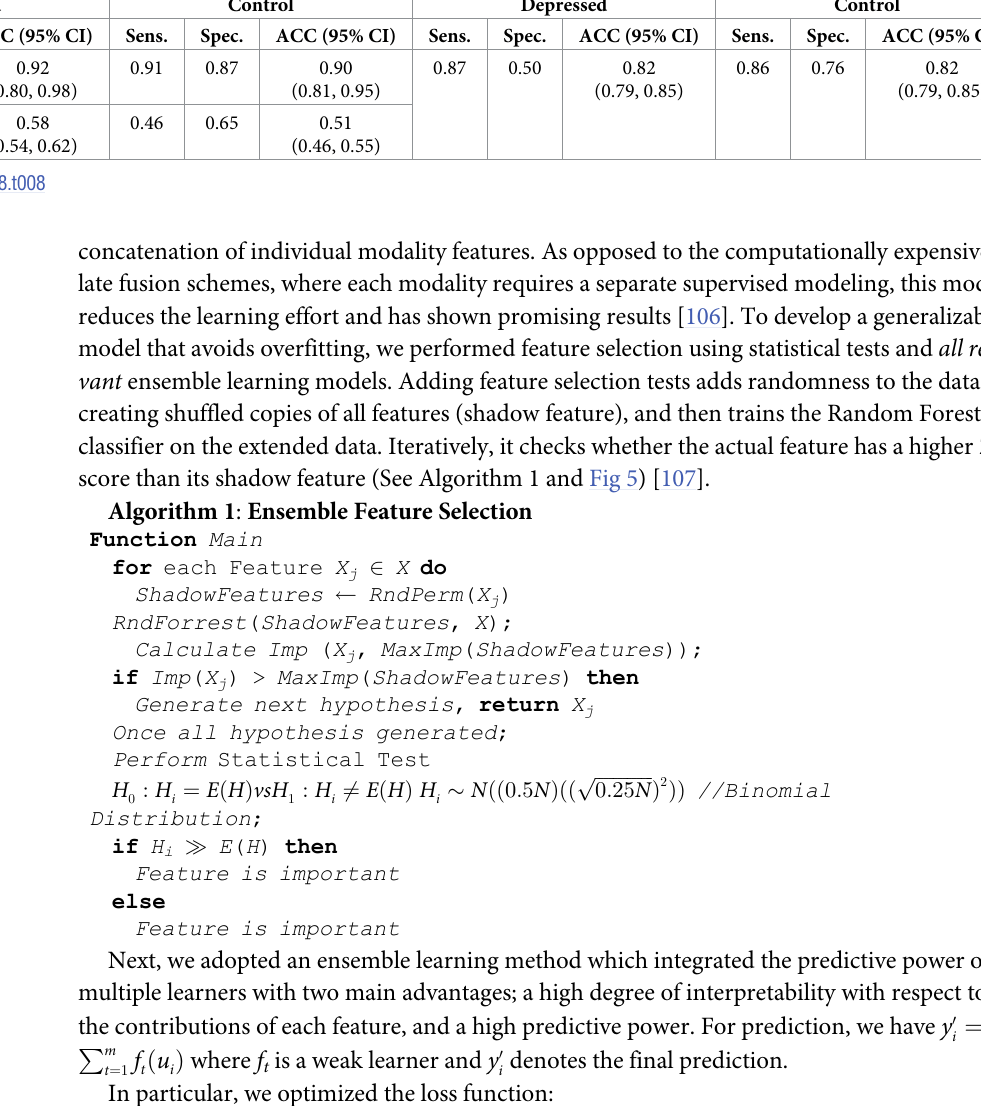
Table 8. Gender prediction performance through visual and textual content. Face found